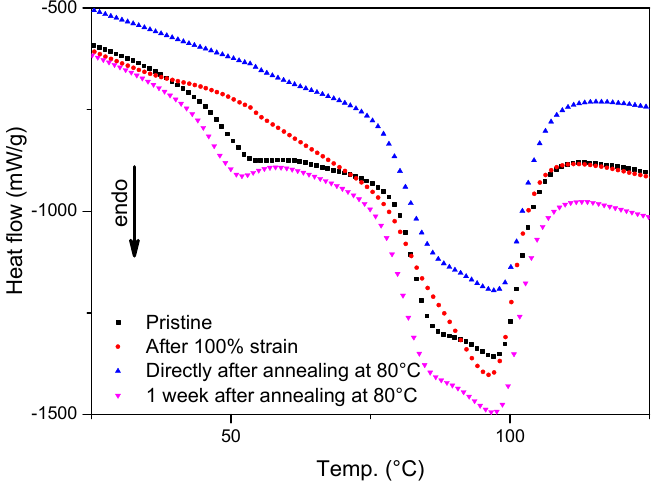
Figure 2. DSC thermograms of the Zn-EMAA-Fe 3 O 4 composite at different stages of the deformation and thermal treatment process.